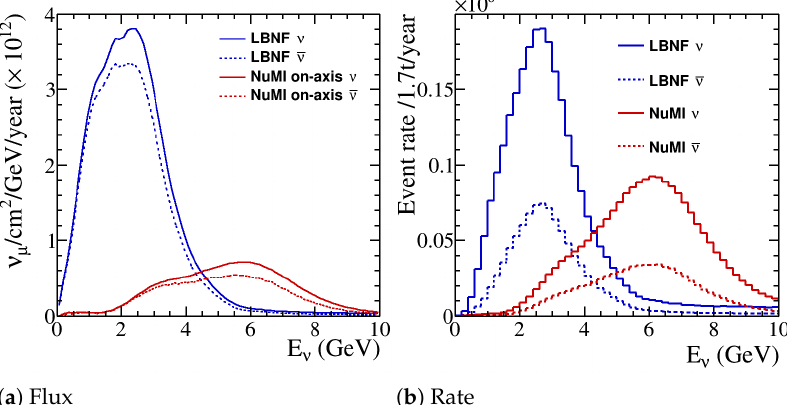
Figure 19. Comparison of the absolutely normalized fluxes for different neutrino beamlines at Fermilab, and the expected yearly rates in the ArgonCube demonstrator’s 1.7t active LAr mass as a function of E ν , produced using GENIE v2.12.10 [71].